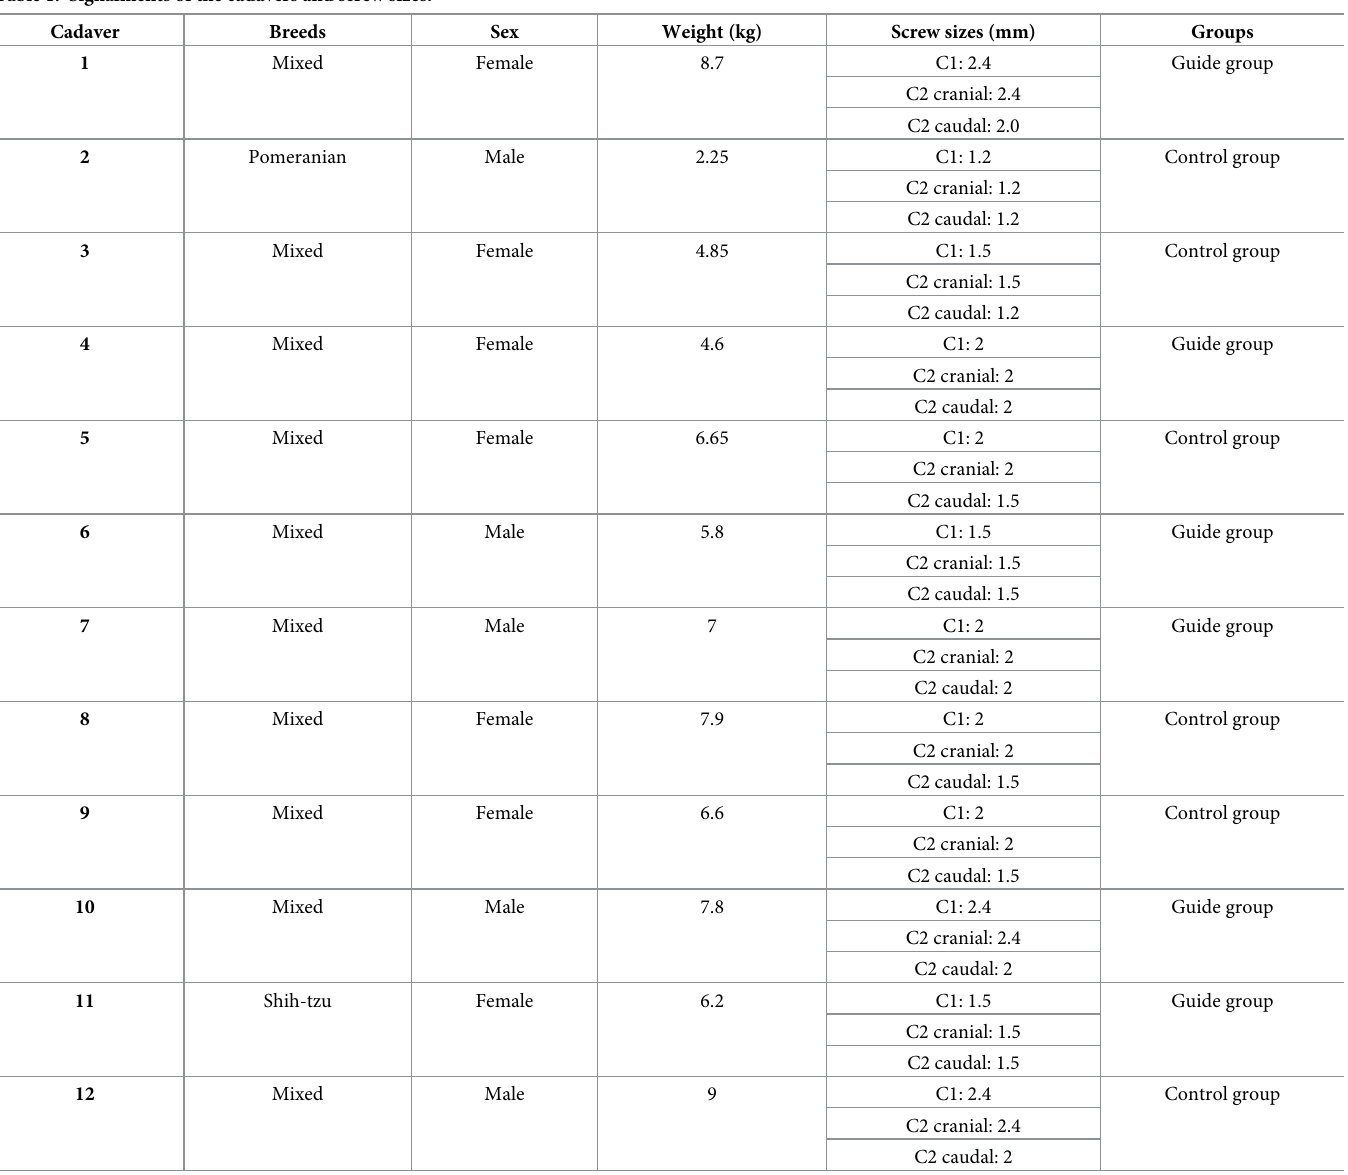
Table 1. Signalments of the cadavers and screw sizes.